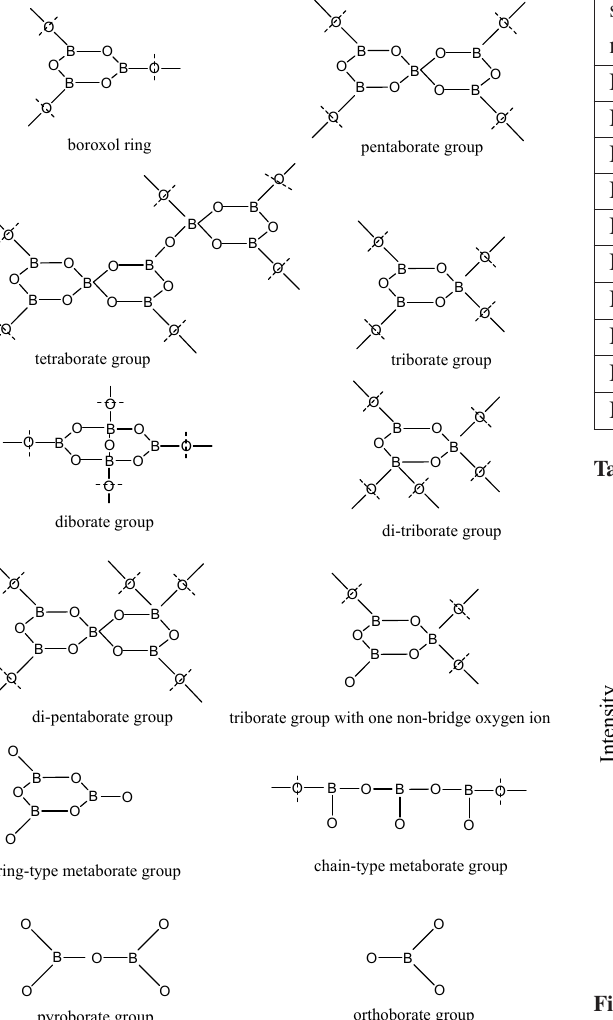
Figure 1. Borate structure groups observed in several bo- rate compounds. Oxygen ions with dotted lines are the bridging type.